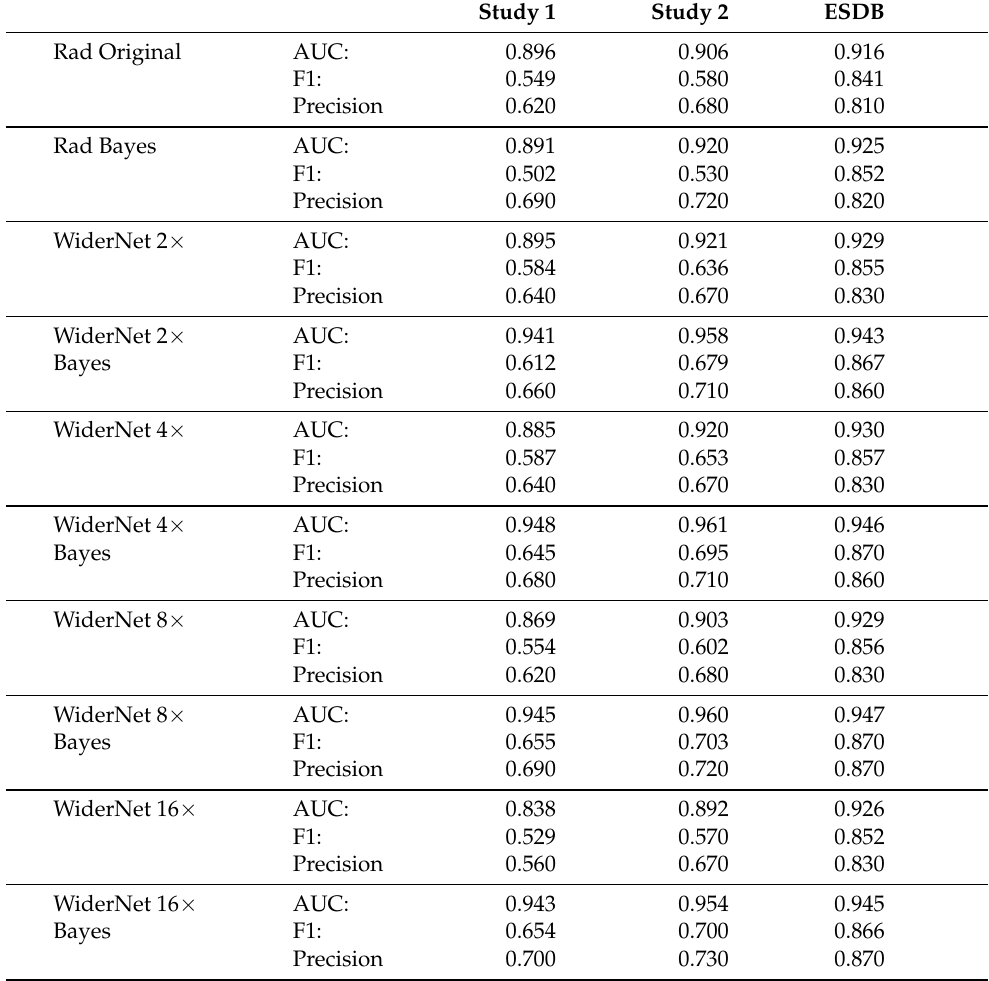
Table 3. Summary of averaged performance for each